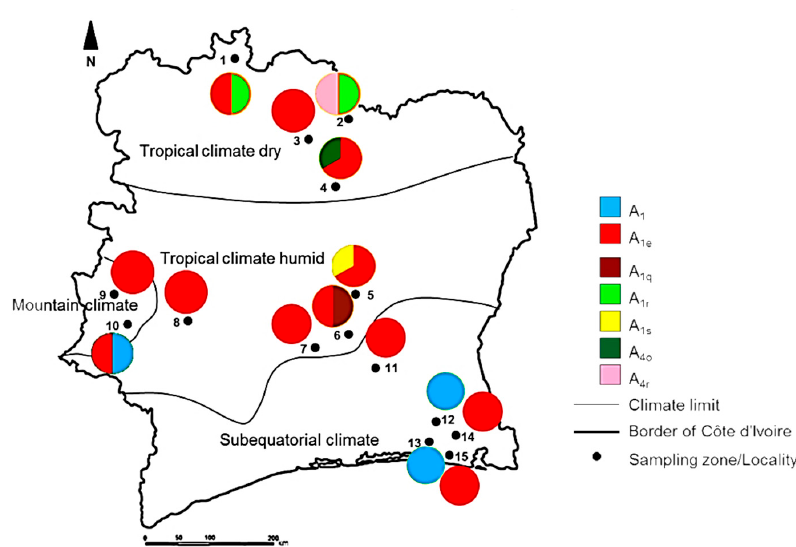
Figure 5. Map of Côte d’Ivoire showing the distribution of COI - COII according to the sample locations (1 to 15). Pie-charts indicate the frequencies of sequence at each location based on our collected samples.